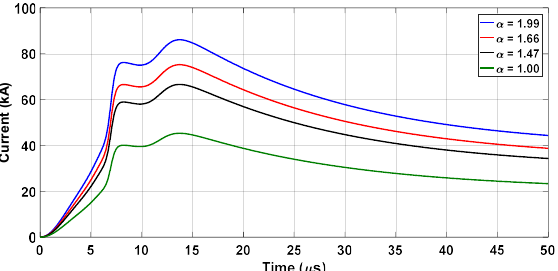
Figure 6. Simulated first stroke current waveforms considering different values of current peak.